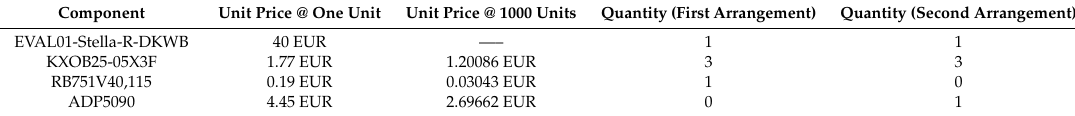
Table 5. Cost comparison (prices from Digi-Key or manufacturer website).